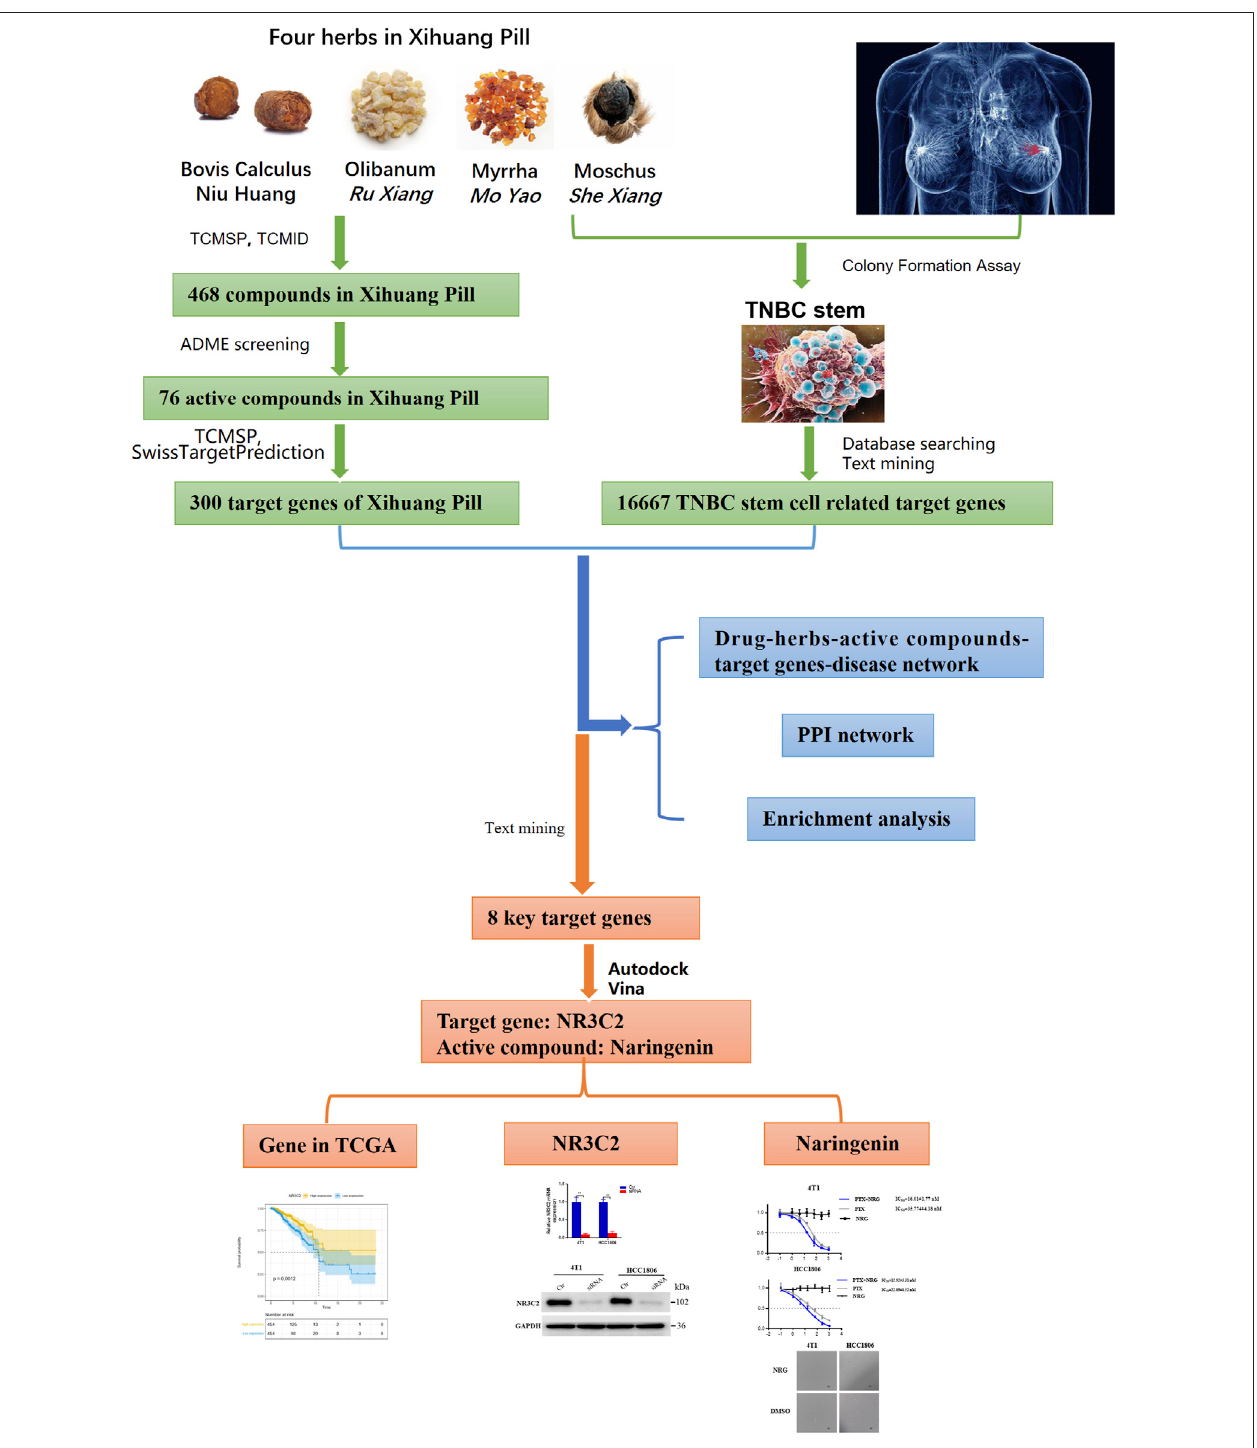
FIGURE 1 | Work fl ow of this